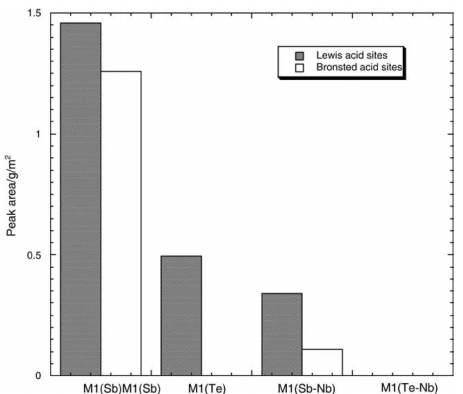
Figure 9. Comparison of the Brønsted and Lewis relative acidity of the M1 phases of MoVTe(Sb)NbO, expressed as area under the pyridine peaks at 1540 and 1450 cm ´ 1 normalized by surface unit in the spectra recorded after desorption at 100 ˝ C, From [60], Copyright 2015, Elsevier